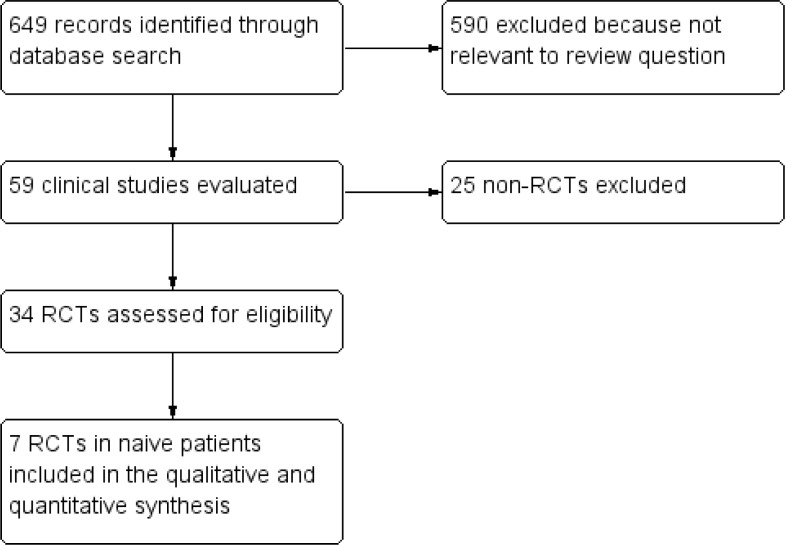
Study flow diagram.